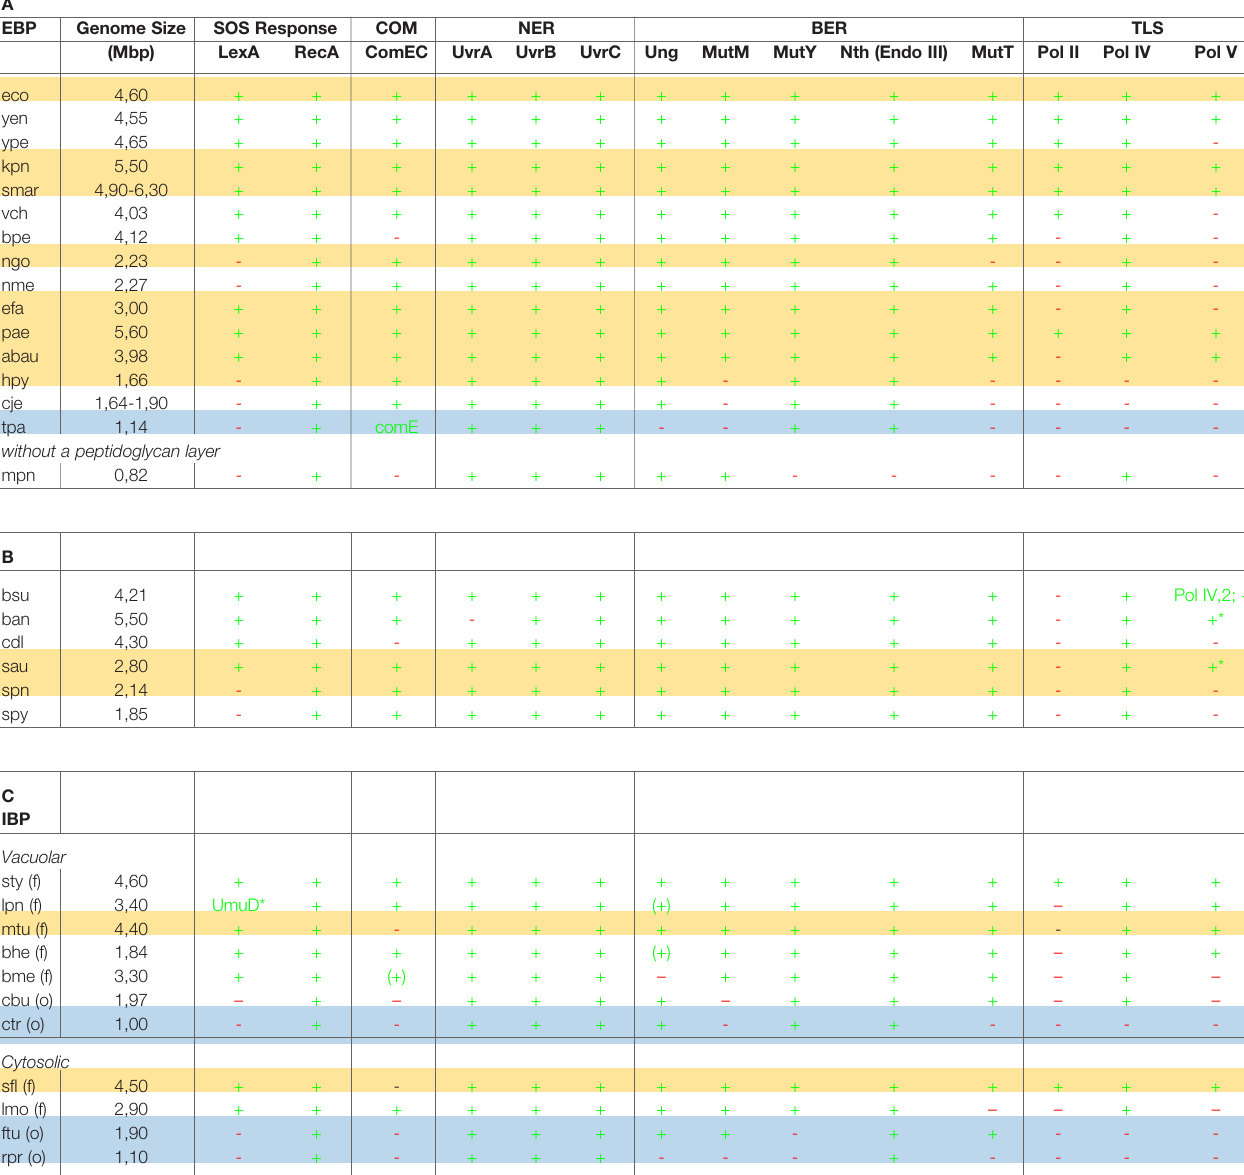
TABLE 2 | EBPs and IBPs and their regulons and pathways involved in DNA repair. A EBP Genome Size SOS